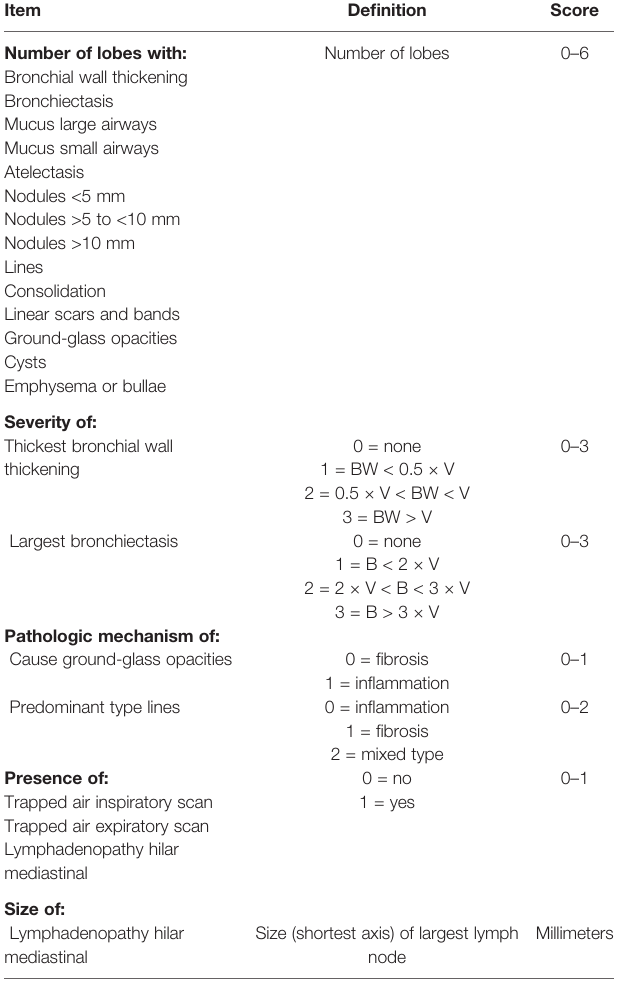
TABLE 1 | Variables of Baumann ’ s scoring